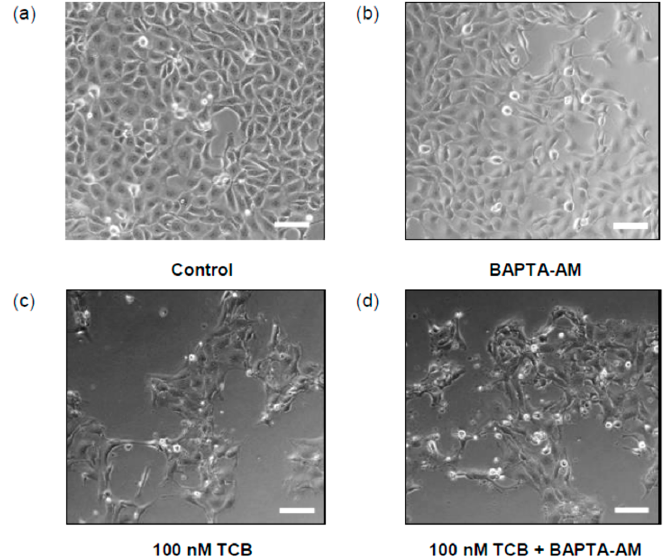
Figure 8. Effect of BAPTA-AM on morphology of LLC-PK1 cells treated with telocinobufagin (TCB). Serum-starved LLC-PK1 cells were treated with 100 nM TCB and/or 5 µ M BAPTA-AM in 2.5% FBS for 24 h and phase-contrast microscopy was performed for control ( a ), BAPTA ( b ), and TCB-treated cells without ( c ) or with BAPTA ( d ). Scale bar: 100 µ